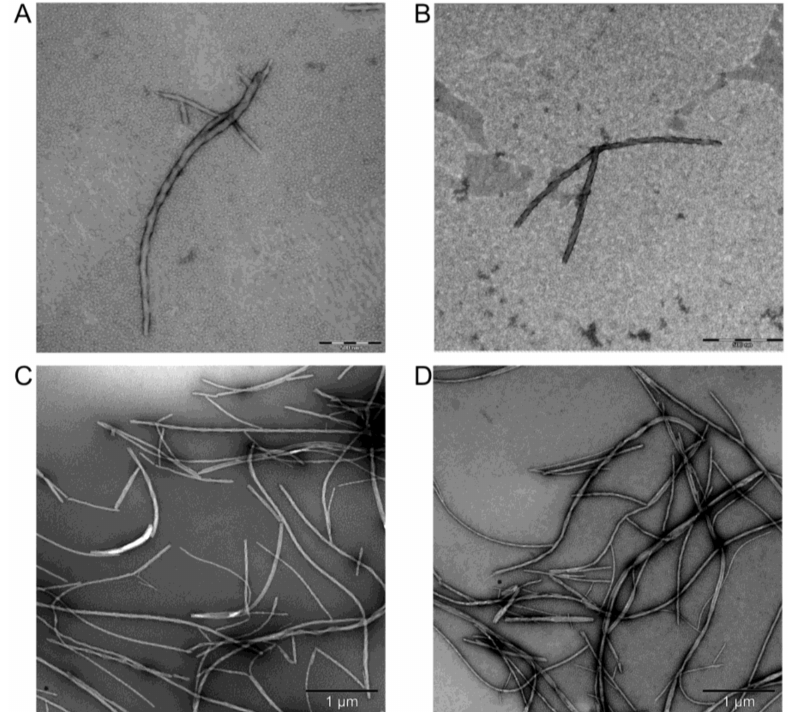
Figure 7. TEM images of Id2’ fibrils. The protein solution in pure water (1.2 mM) was kept at 5 ◦ C for a period of four weeks. Images of aliquots diluted to 50 µ M and negatively stained with uranyl acetate after 16 h ( A and B : scale bar = 500 nm) and four weeks ( C and D : scale bar = 1 µ m) are